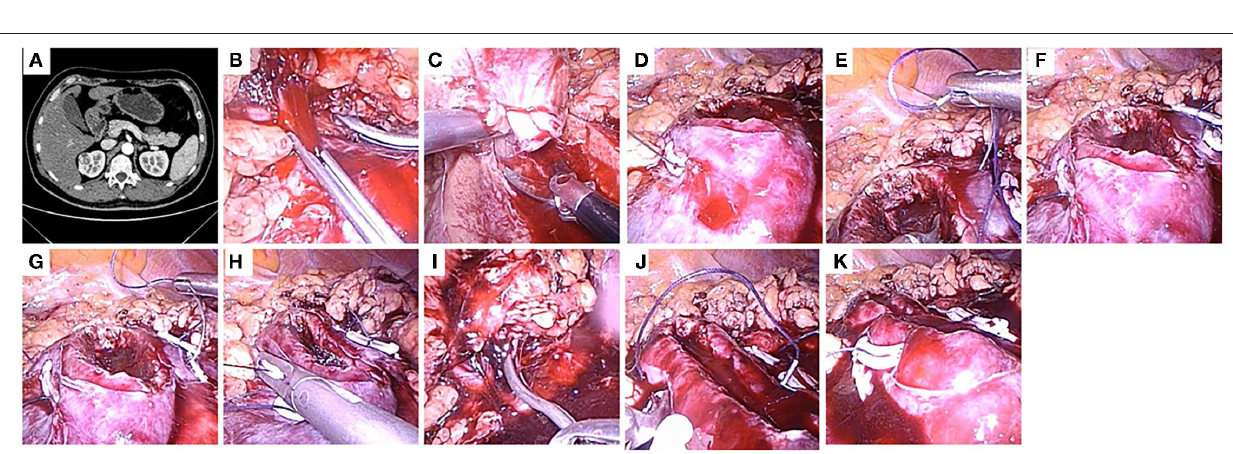
two groups with respect to all comparable parameters. The